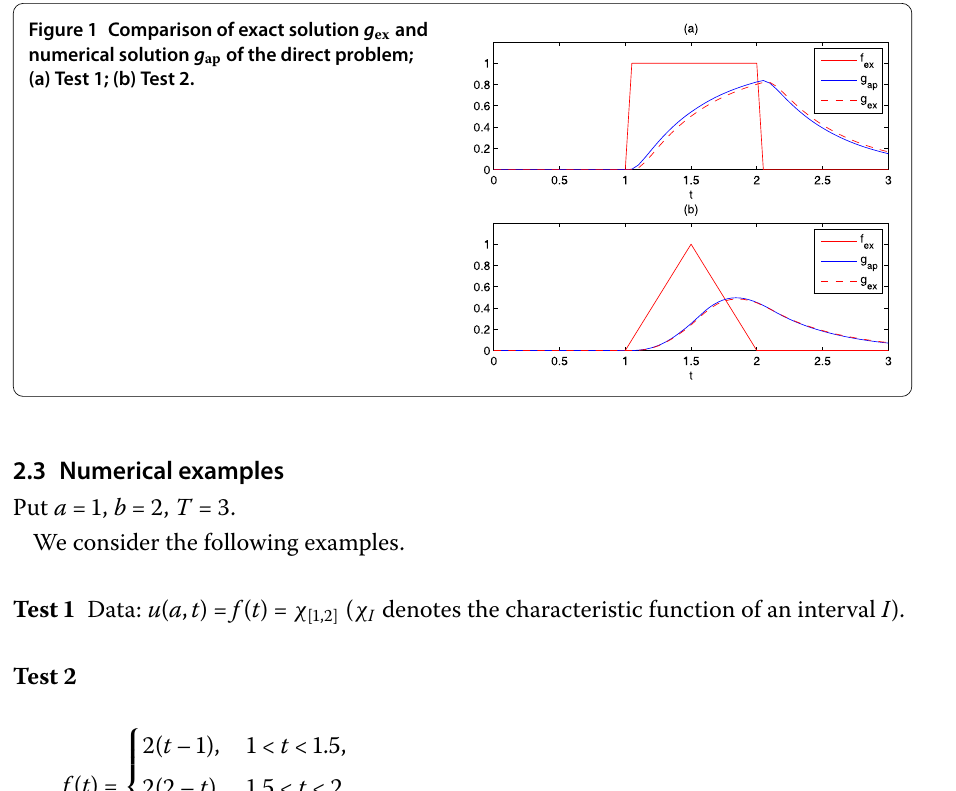
Figure 1 Comparison of exact solution g ex and numerical solution g ap of the direct